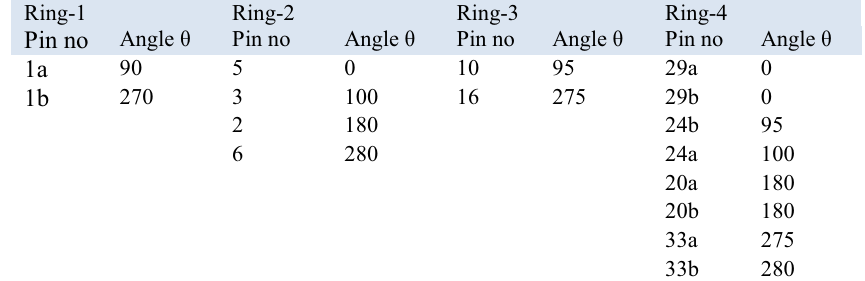
Table 2: Circumferential position of thermocouple in fuel pin at section C and D Ring-1